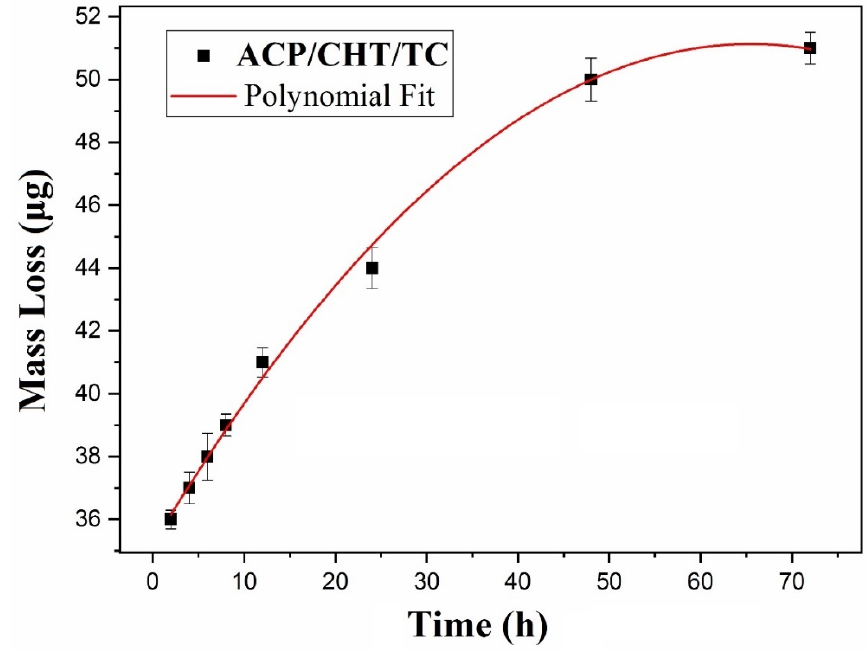
∆ m , as a function of immersion time in SBF, t Figure 9. Mass Loss Release, Δm, as a function of immersion time in SBF, t. Figure 9. Mass Loss Release,